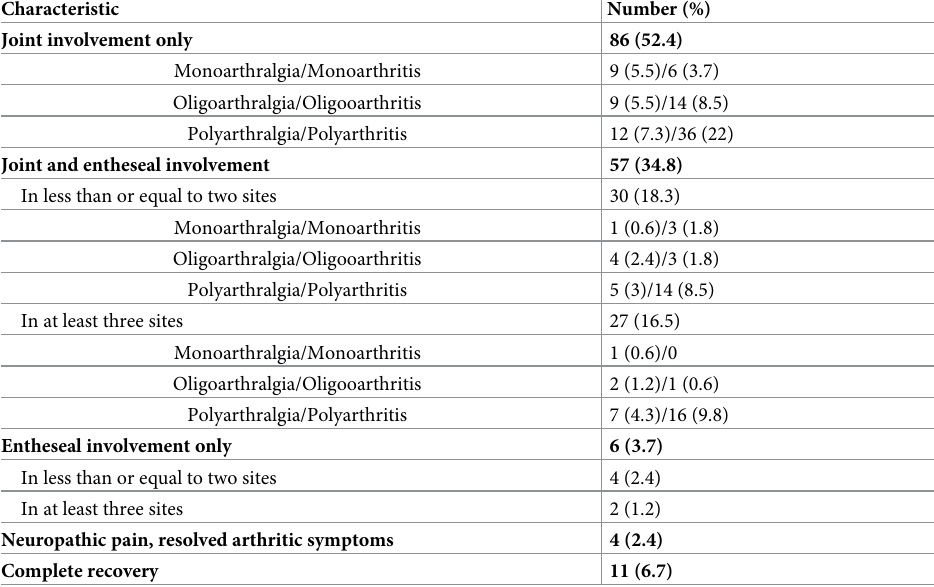
Table 2. Patterns of joint and/or entheseal involvement at the first assessment by a rheumatologist (n = 164).